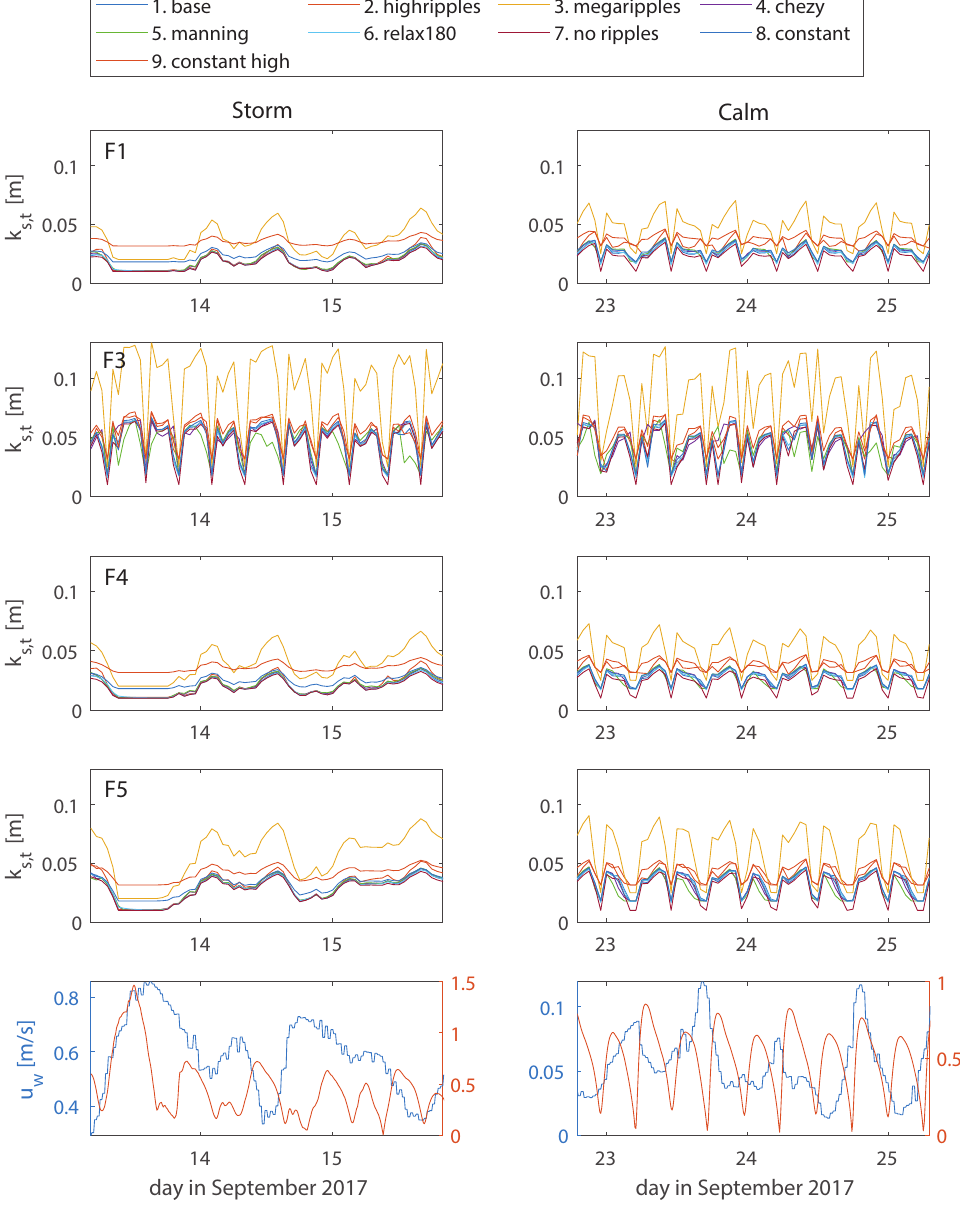
Figure 5. Top four rows: modelled total bedform roughness k s through time at all frame locations (F1, F3, F4 and F5) during the storm ( left ) and the calm ( right ) period as denoted in Figure 3. Bottom row: modelled near-bed orbital velocity and depth-averaged current velocity magnitude at Frame 1 during the storm ( left ) and the calm ( right )